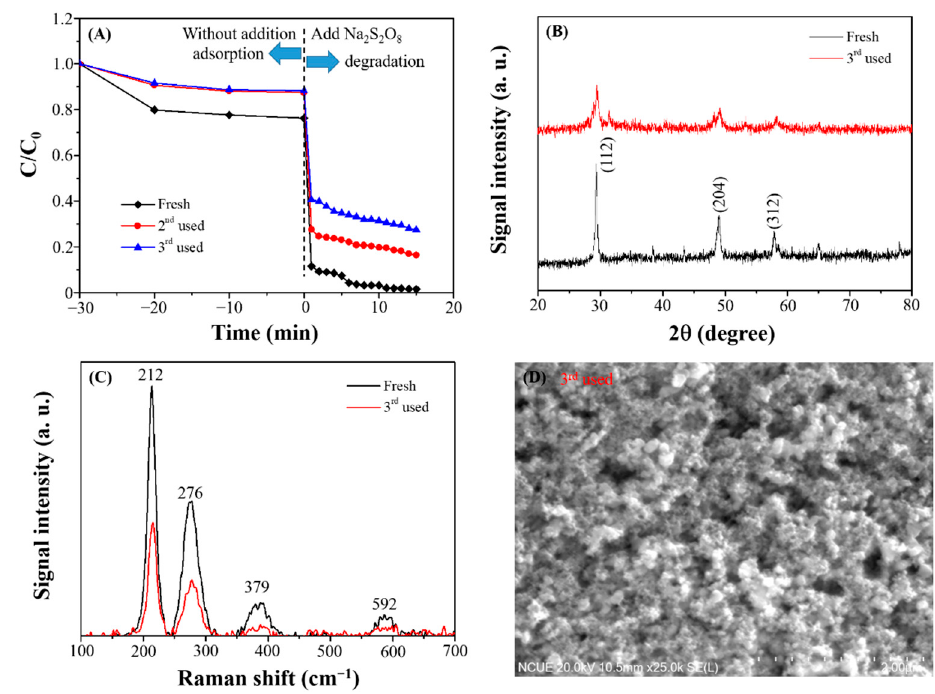
Figure 14. ( A ) Fenton-like reaction for RhB degradation by the H-CuFeS 2 samples for the recycling-used test, ( B ) XRD, ( C ) Raman spectra, and ( D ) SEM image of the 3rd used samples.